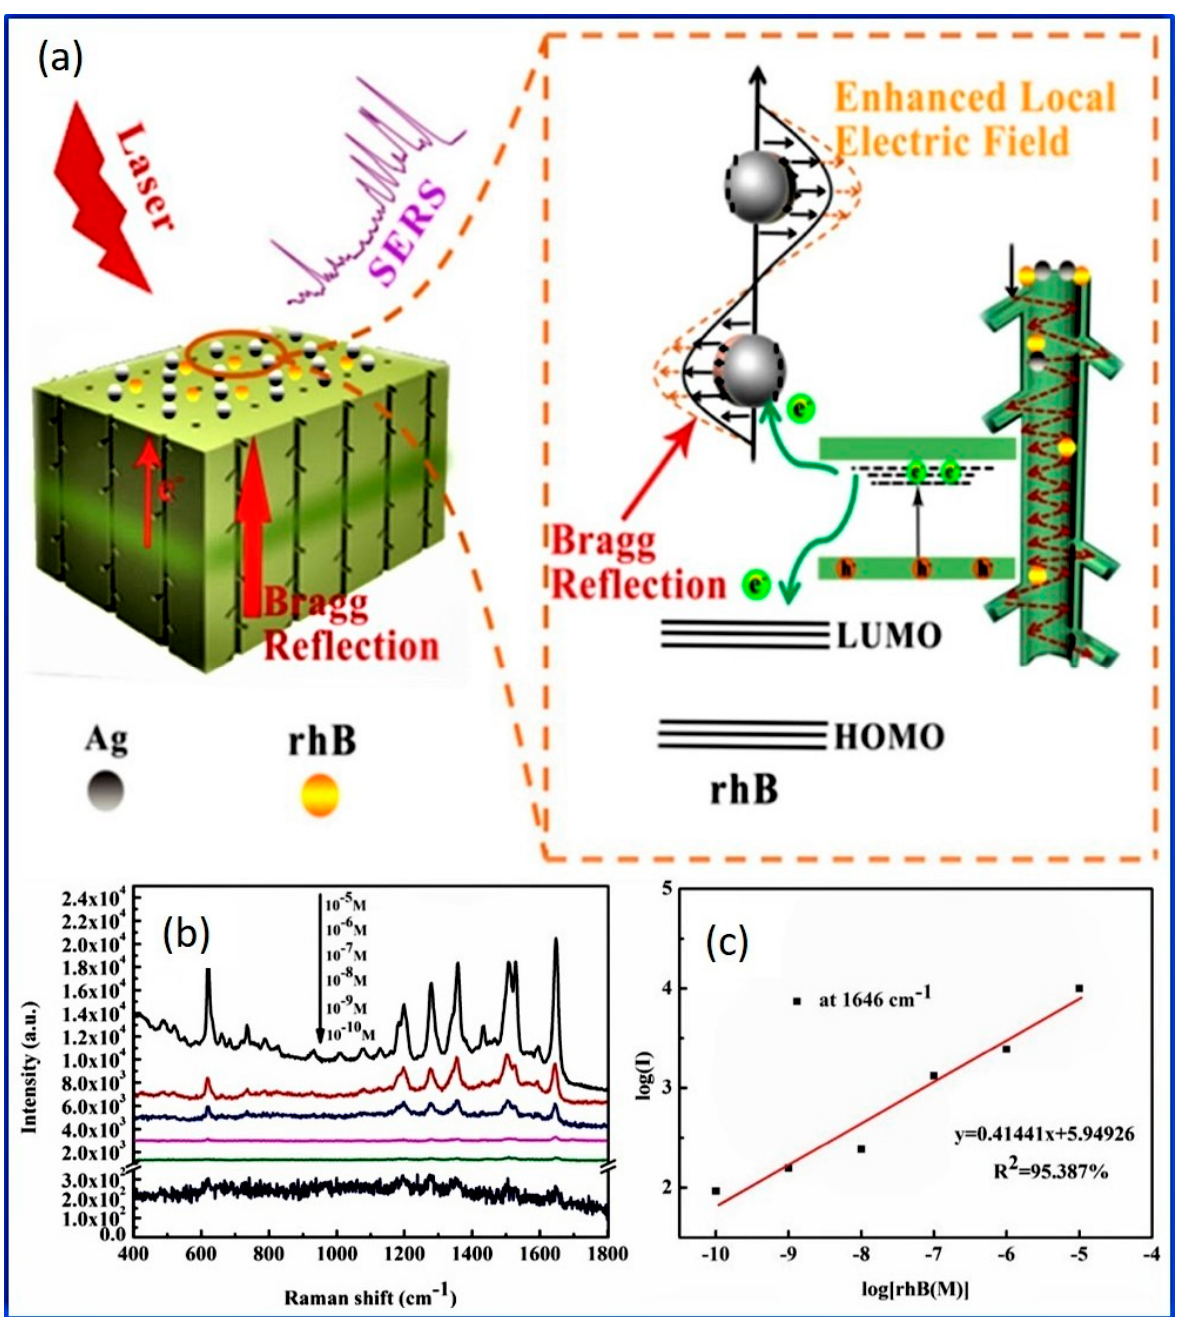
Figure 14. NAA ‒ DPC used for SERS applications. ( a ) Schematic showing the SERS enhancement mechanism using RhB on the silver decorated NAA ‒ DPC; ( b ) Raman spectra of RhB on silvered NAA ‒ DPC; and ( c ) variation of Raman intensity with RhB concentration. Reproduced with permission from Xiao-Gang Wang, Jian Wang, Jian-Feng Li, Dai-Wen Tao, Wen-Ming Zhou, Yan Li, and